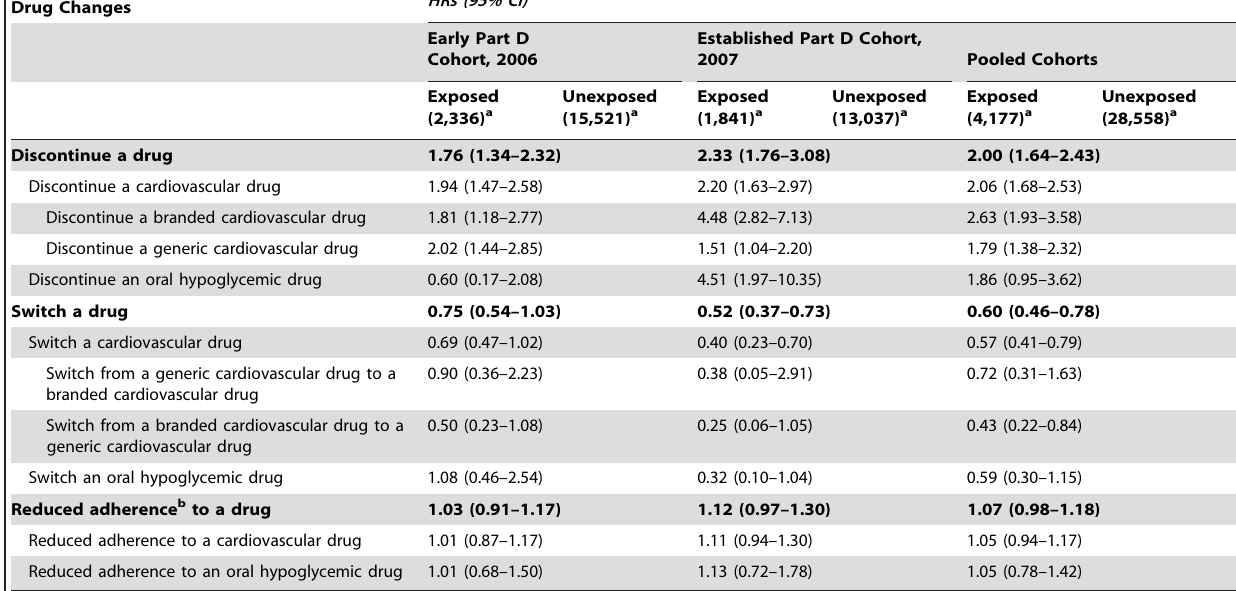
Table 3. Drug-level analyses.